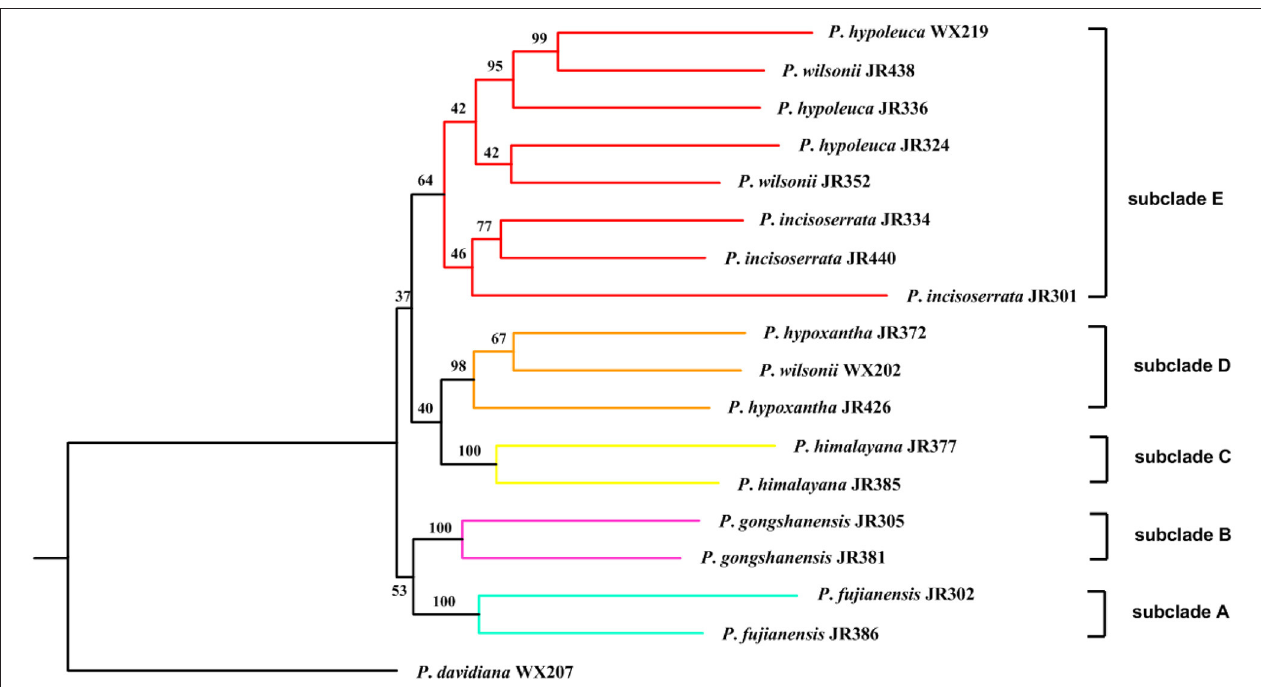
FIGURE 9 | Maximum likelihood inferred from 446 single-copy nuclear (SCN) genes of Maddenia group of Prunus . The number above branch indicated bootstrap support from the IQ-TREE.